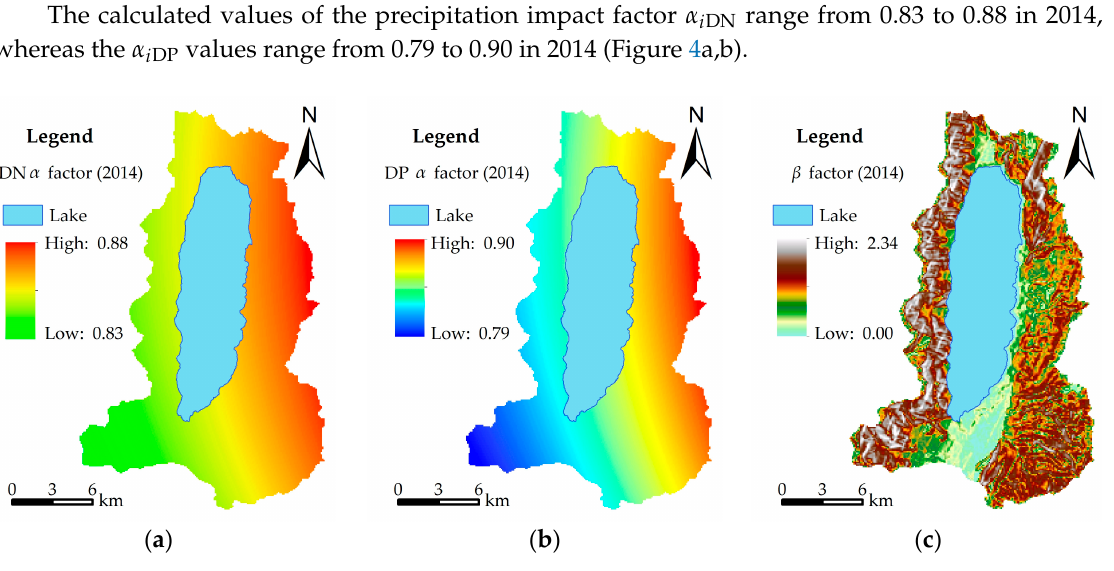
Figure 4. Spatial distributions of the values of the precipitation impact factor ( a , b ) and the terrain impact factor ( c ).